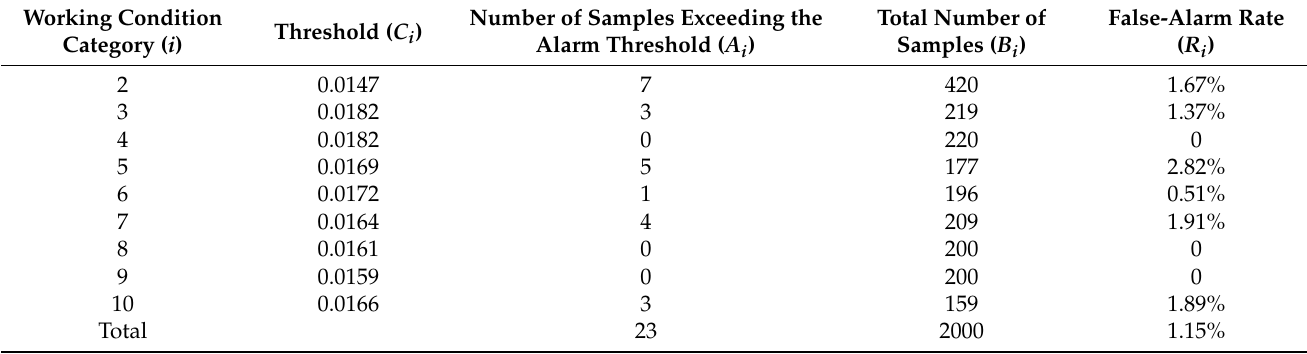
Table 6. Alarm thresholds and false-alarm rates under different operating